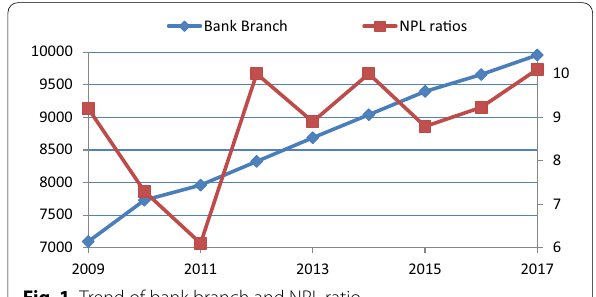
Fig. 1 Trend of bank branch and NPL